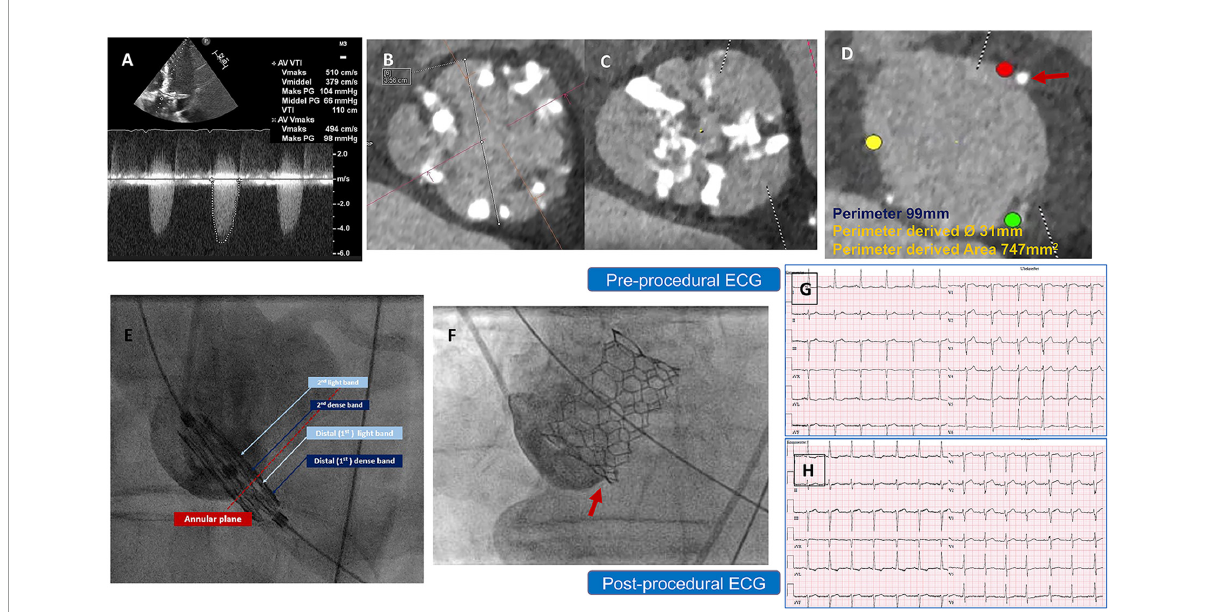
FIGURE1 (A) Preprocedural AV CWD recording from Apical 5 chamber view, with high maximum velocity = 5.1 m/s, mean PG = 66 mmHg (B) inter commissural distance (4–5 mm) above the annular level = 35 mm, (C) AV significant calcification at the raphe level (D) annulus measurement showing small annular calcific nodule, and (E) illustration of the Myval design showing the dense (dark blue arrows), light bands (light blue arrows) and deployment within the annular plane (red dotted line) to obtain a proper position and implantation depth. (F) Implantation depth (G,H) pre and postprocedural ECG without changes. AV, Aortic valve, BAV, Bicuspid Aortic Valve, CCTA, Cardiac Computed Tomography, CWD, continuous wave Doppler, ECG, Electrocardiogram, PG, Pressure